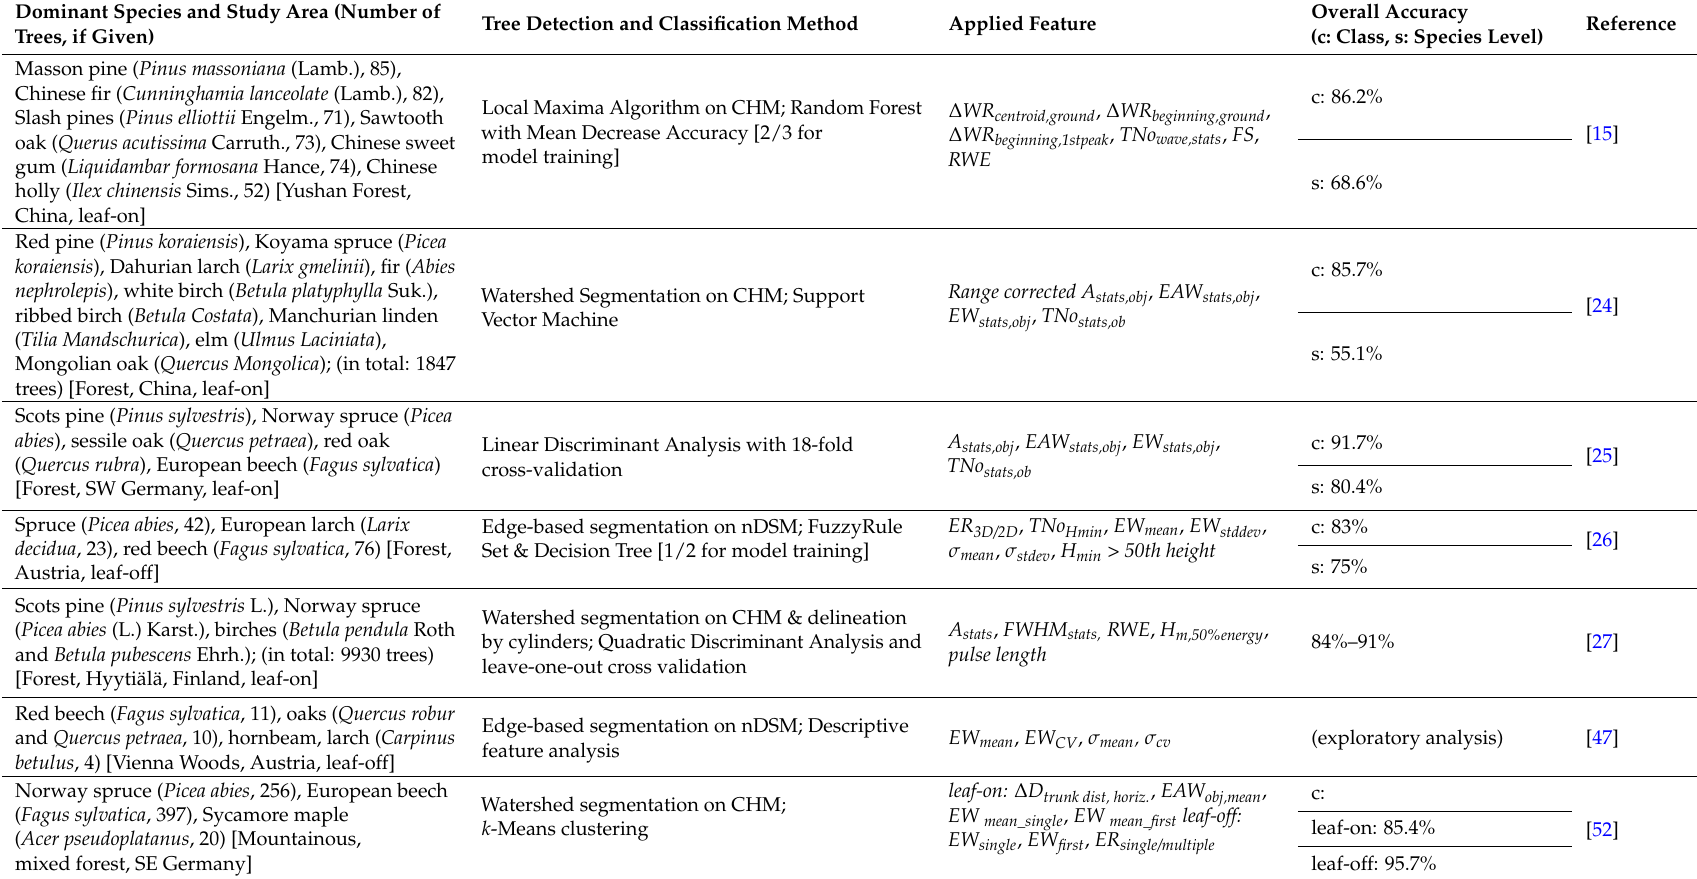
Table A3. Overview of applied feature sets for species classification and the overall accuracies achieved by different studies. Dominant Species and Study Area (Number of Tree Detection and Classification Method Applied Feature Trees, if Given)